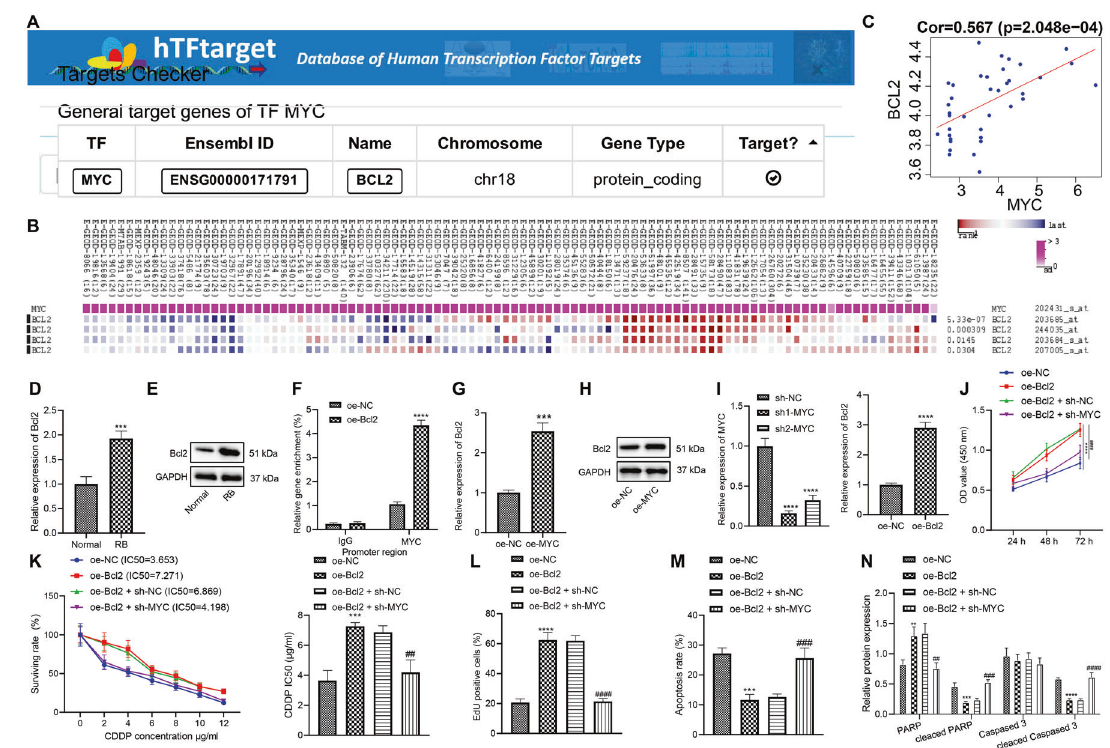
Fig. 4 Myc promotes Bcl2 expression to inhibit chemosensitivity of WERI-RB-1/CDDP cells. A The relationship between Myc and Bcl2 identi fi ed by hTFtarget. B Co-expression of Myc and Bcl2 explored by MEM analysis. C The positive correlation between Myc and Bcl2 certi fi ed by the analysis of microarray GSE28133. D Differential expression of Bcl2 in retinoblastoma determined by RT-qPCR. E Differential expression of Bcl2 in retinoblastoma determined by western blot analysis (* p < 0.05 vs. normal tissues). F The binding of Myc to the Bcl2 promoter binding detected by ChIP assay. G Bcl2 expression determined by RT-qPCR. H Bcl2 expression determined by western blot analysis. I Myc silencing and Bcl2 overexpression ef fi ciency determined by RT-qPCR (* p < 0.05 vs. cells transfected with oe-NC or sh-NC). J Cell viability assessed by CCK8 assay. K IC 50 value determined by CCK8 assay. L Cell proliferation assessed by EdU assay. M Cell apoptosis assessed by fl ow cytometry. N Expression of PARP, Cleaved PARP, caspase 3, and Cleaved caspase 3 in cells after transfection determined by western blot analysis. * p < 0.05 vs. cells transfected with oe-NC; # p < 0.05 vs. cells co-transfected with oe-Bcl2 + sh-NC. */# p < 0.05; **/## p < 0.01; ***/### p < 0.001; ****/#### p < 0.0001. The experiment was independently repeated three